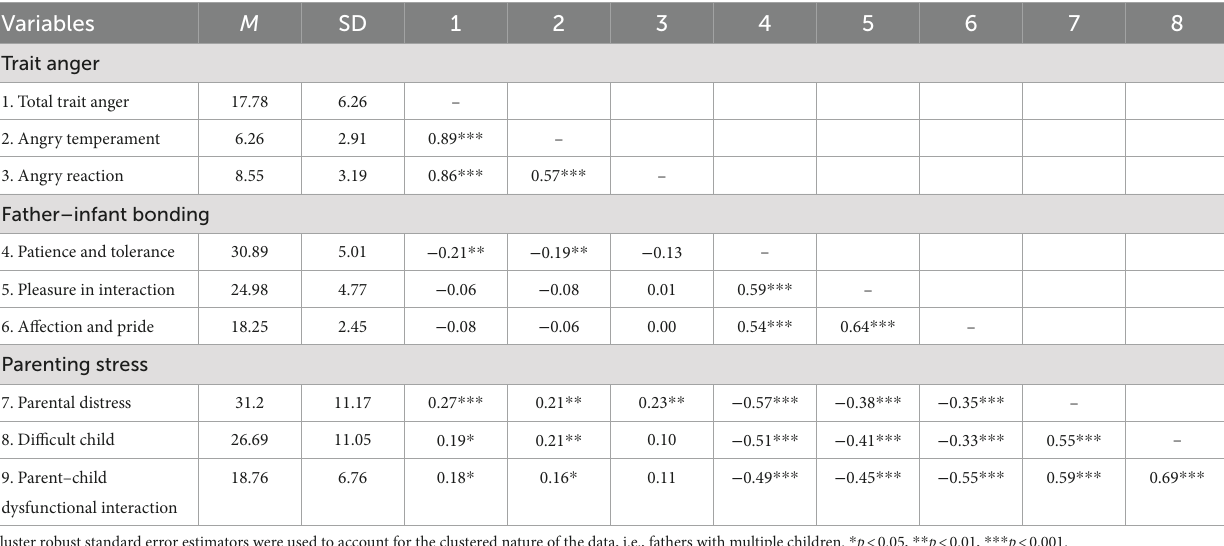
TABLE 2 Means, standard deviations, and correlations of key study variables.